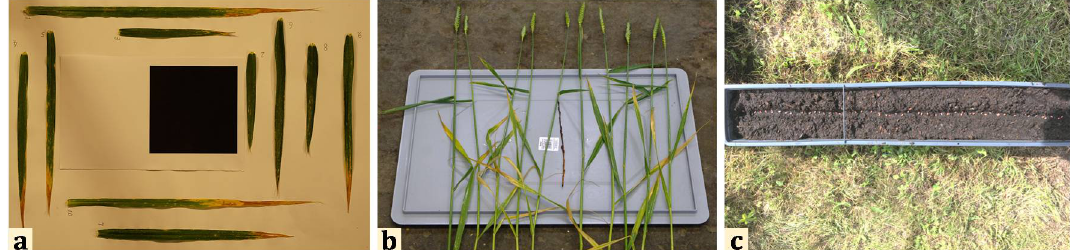
Figure 6. Measurement for validation including ( a ) leaf length and width measurement in the last trial, ( b ) leaf parameters estimation in the last trial (destructive method), and ( c ) representation of a single row with different wheat density.